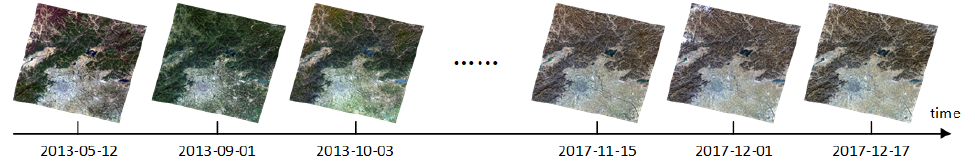
Figure 1. An example of multi-spectral satellite image time series (SITS) with Landsat 8 OLI images of path 123 and row